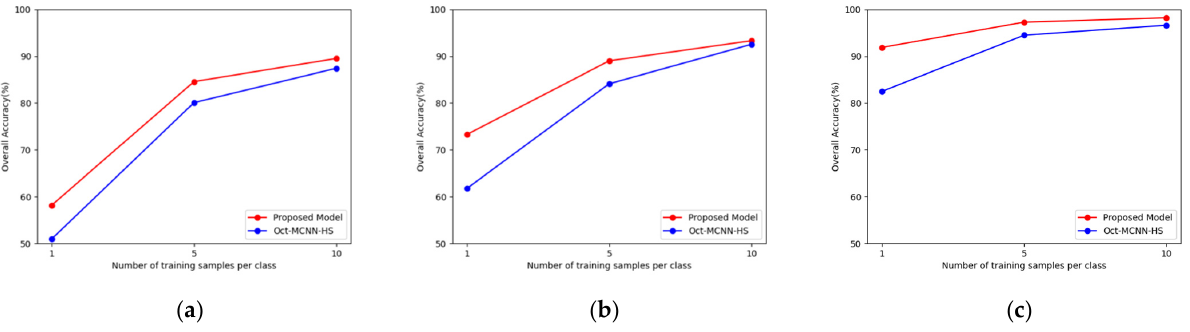
Figure 15. OA curves for different methods with different numbers of training samples on different training dataset. ( a ) OA curves on IP dataset; ( b ) OA curves on PU dataset; ( c ) OA curves on SA dataset.